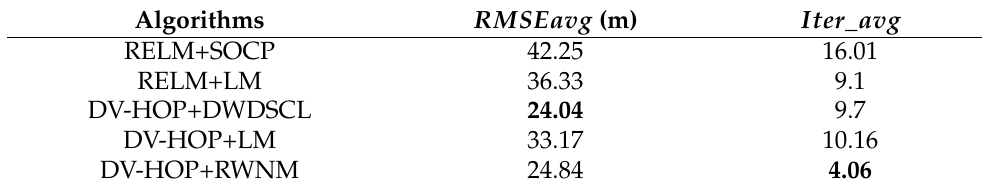
Table 3. RMSEavg and Iter _ avg at different outliers values using R = 35 m and nfe = 0.3, the best performances in RMSE average and iteration average are denoted in bold